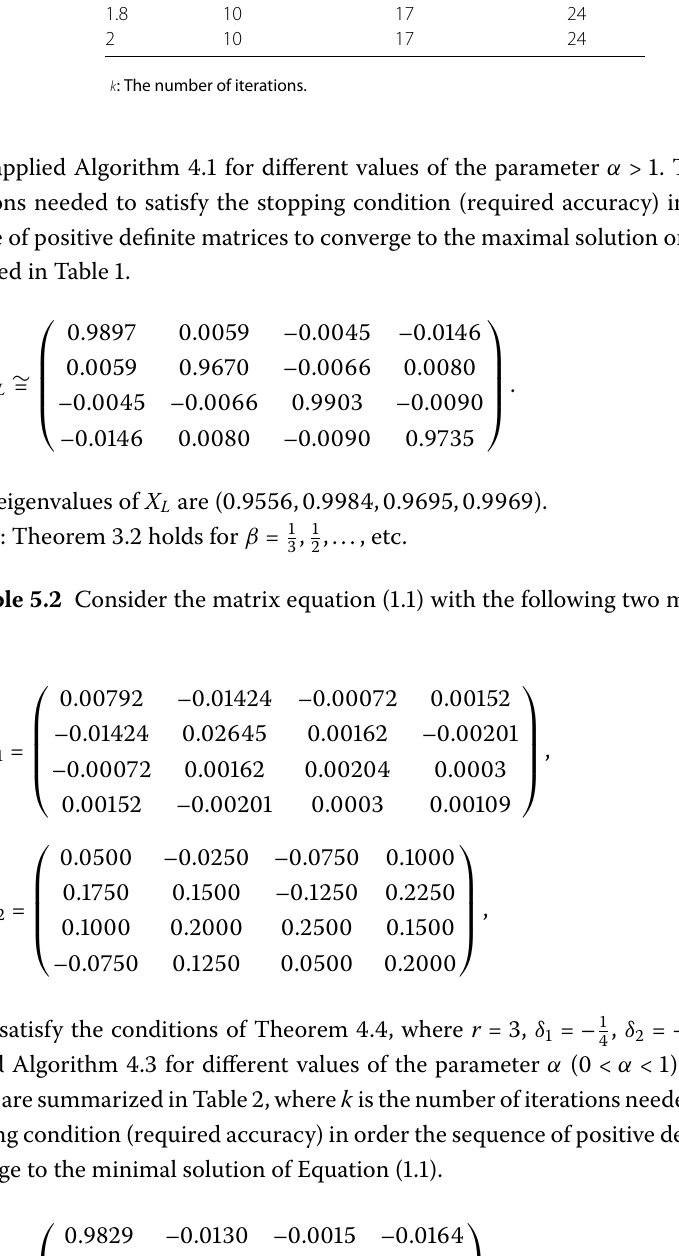
Table 1 INVERSE-FREE iterative Algorithm 4.1 α k tol = 10 –4 tol = 10 –6 tol = 10 –8 1.2 7 14 21 1.4 8 15 22 1.6 9 16 23 1.8 10